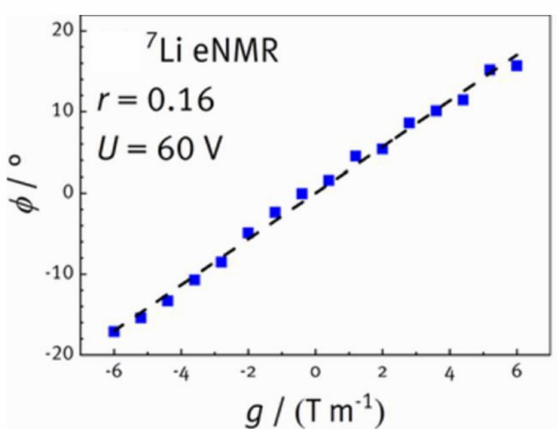
Figure 6. Plot of phase shift, determined via electrophoretic NMR, as a function of gradient strength for lithium cations in LiTFSI-doped PEO at 90 ◦ C and a molar ratio of lithium to ether oxygen of 0.16. © Journal of the Electrochemical Society, 20